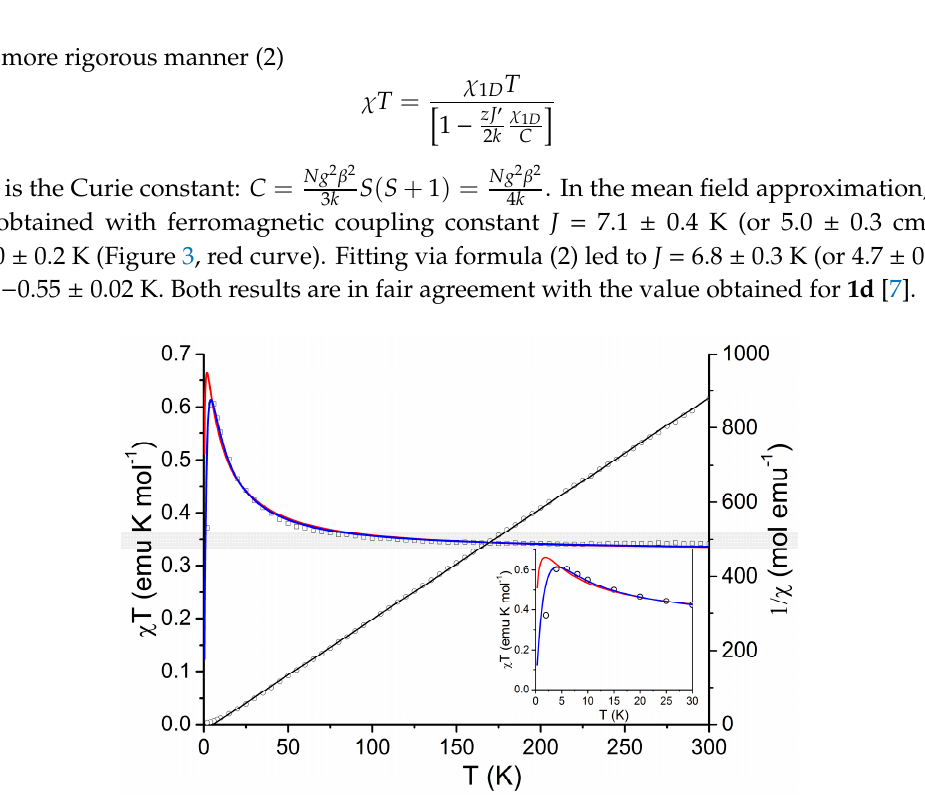
Figure 3. χ T and 1/ χ versus T plots for 1a . The straight line corresponds to the best fit of 1/ χ (Curie–Weiss law), and the curves correspond to the best fit of χ T using the 1D-Heisenberg ferromagnetic model and taking into consideration antiferromagnetic interactions by means of formulas 1 (red curve) and 2 (blue curve).